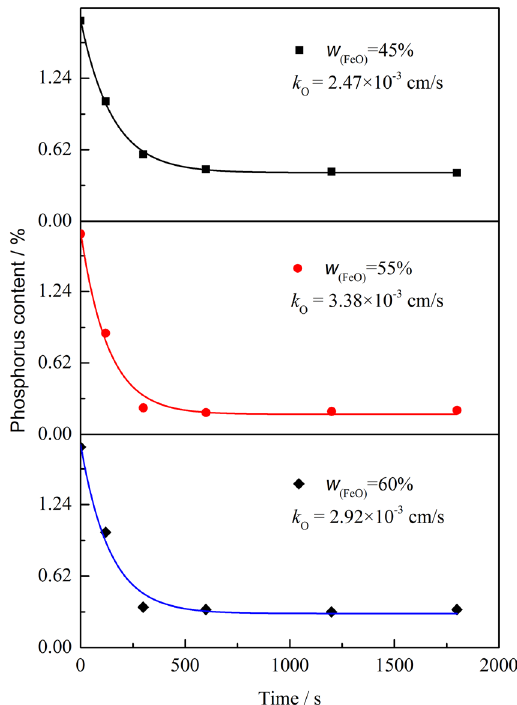
Figure 5: Variation of the P content as a function of time when the FeO content ranged from 45 to